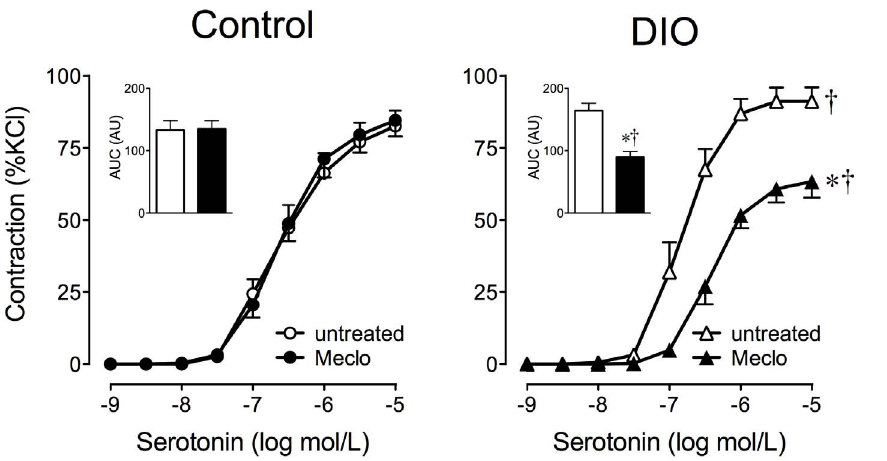
Figure 5. Cyclooxygenase inhibition prevents perivascular adipose-dependent potentiation of contractions to serotonin in diet- induced obesity. Aortic rings with perivascular adipose (PVAT) from WT mice with diet-induced obesity (DIO) or lean WT mice (control) mice were exposed to increasing concentrations of serotonin in the presence or absence of the cyclooxygenase inhibitor meclofenamate (Meclo, 1 m mol/L). DIO animals were fed a high-fat diet for 24 weeks and compared to age-matched mice fed a standard chow (control). Inset: Area under the curve (AUC) is expressed as arbitrary units (AU). # , control, untreated ( n =6); control, meclofenamate ( n =4); n , DIO, untreated ( n =7); m , DIO, meclofenamate ( n =5). * p , 0.001 vs. untreated vascular rings; { p , 0.05 vs.